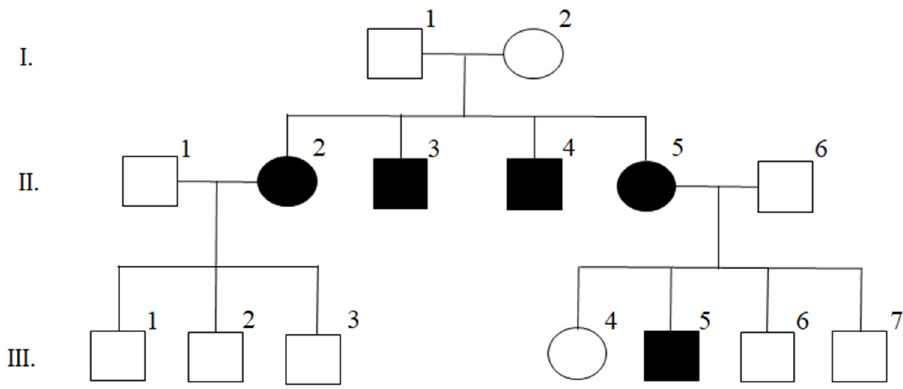
Figure 1. Index family pedigree. Individuals with shaded symbols are affected by MS.